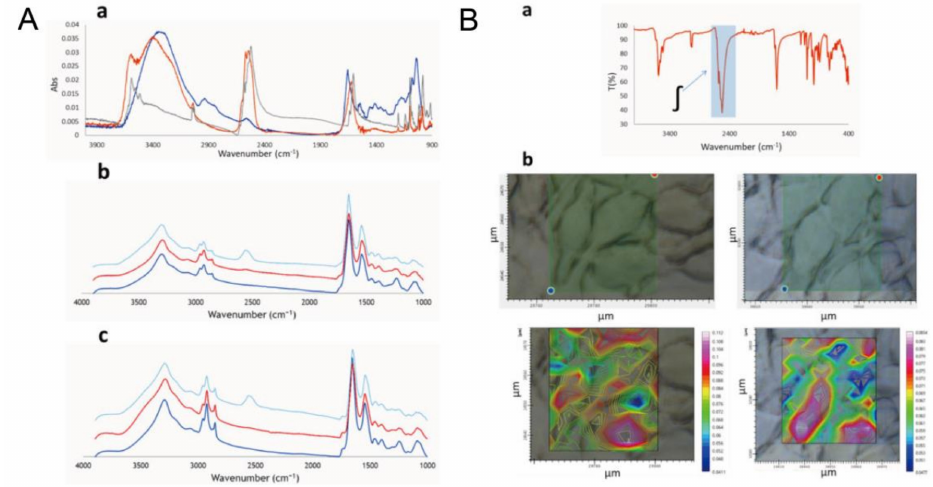
Figure 5. Na[o-COSAN] − uptake analyses and microscopy images of GICs. A: GICs Na[o-COSAN] − uptake analyses by SR-FTIR. ( A) ( a ) Strong bands of ν (B-H) at 2582–2522 cm − 1 and ν (C cluster -H) at 3031 cm − 1 were detected. Gray: Na[o-COSAN] in solid-state; Orange: Na[o-COSAN](2 mM) in aqueous solution; Blue: Na[o-COSAN](2 mM) in culture media solution. ( b ) IR spectra of GIC7 cells. Dark blue: control group; Red: Cells were incubated in Na[o-COSAN](200 µ M)-culture medium for 5 h. Light blue: Cells were incubated in Na[o-COSAN](2 mM)-culture medium for 5 h. ( c ) IR spectra of PB88 cells. Dark blue: control group; Red: Cells were incubated in Na[o-COSAN](200 µ M)-culture medium for 5 h. Light blue: Cells were incubated in Na[o-COSAN](2 mM)-culture medium for 5 h. B: Microscopy images and mappings of GIC7 cells after being treated with Na[o-COSAN](2 mM) for 5 h. ( B) ( a ) The ν (B-H) signals bands at 2620–2460 cm − 1 . ( b ) Corresponding maps of two different areas of culture cells. The intensity of the red color indicates the nuclear localization of Na[o-COSAN]